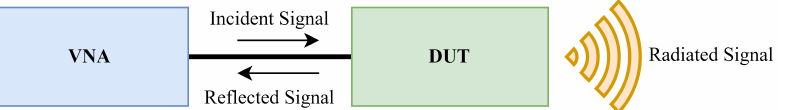
Figure 6. The concept of a radiating element in the context of a vector network analyser (VNA)-based measurement of a device under test